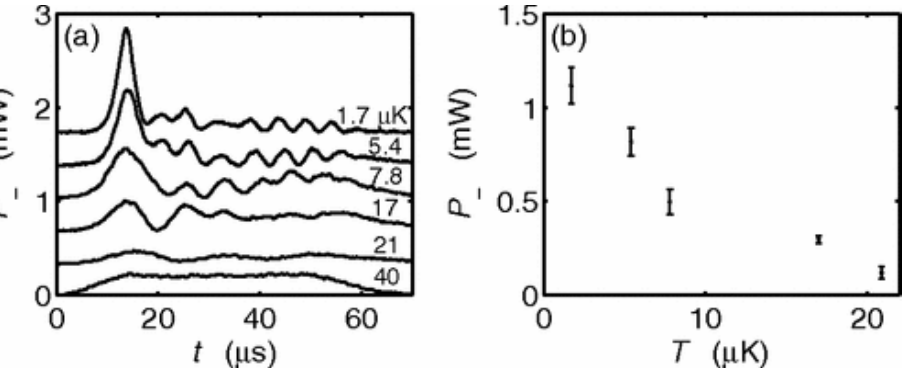
Figure 12. ( a ) Measured time-evolution of the reverse mode at various temperatures. The cavity is operated at high finesse. For clarity, the curves are vertically shifted from one another by 0.35 mW. The atom number is the same for all data points, N = 1.5 × 10 6 . The pump power is P + = 1 W. The reverse power observed at high temperatures is there even without atoms and is caused by mirror backscattering. ( b ) Measured SRyS peak height as a function of temperature. Reprinted with permission from ref. [39]. Copyright 2007 American Physical